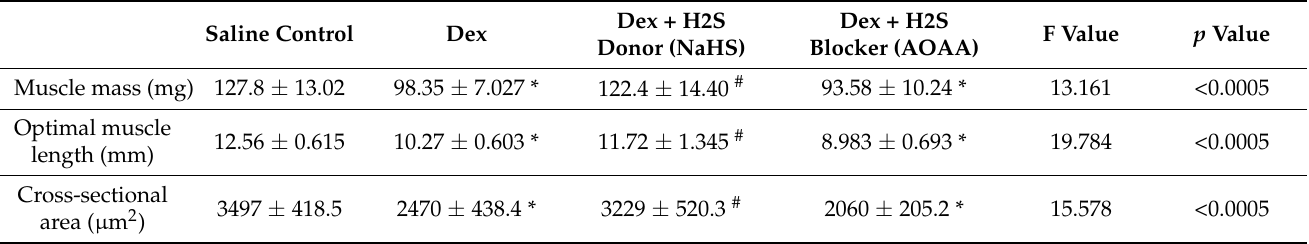
Table 4. General properties of soleus muscle in all experimental groups.